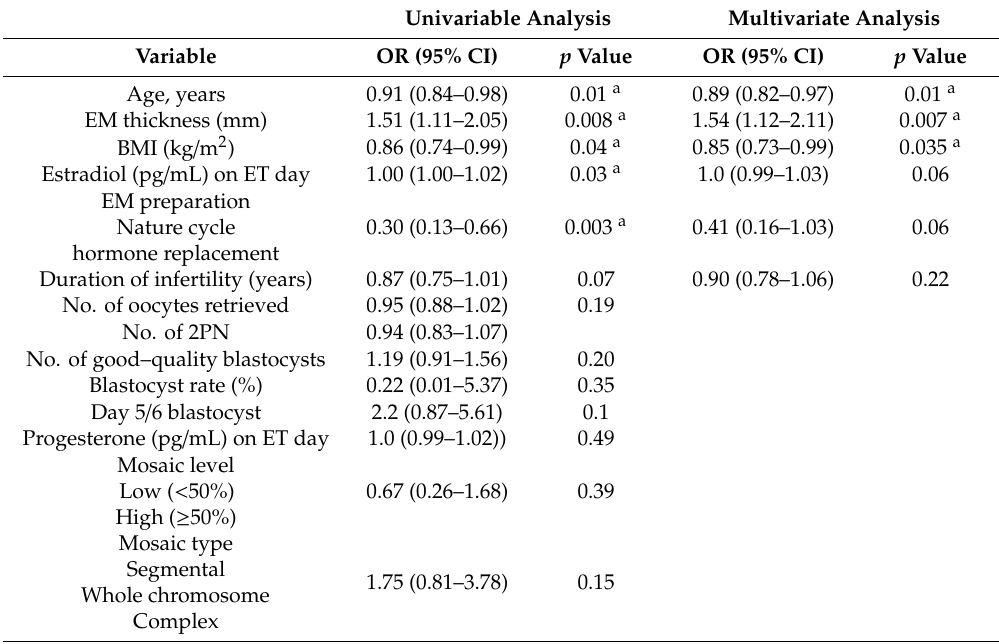
Table 2. Univariate and multivariable logistic regression analyses of factors a ff ecting live birth rate after single mosaic embryo